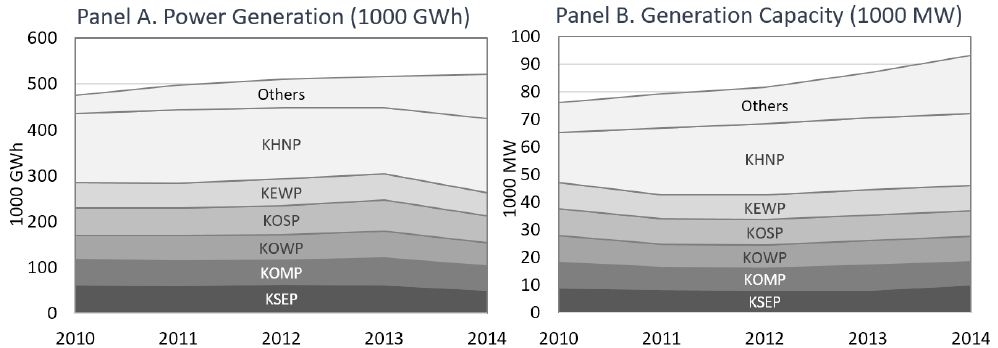
Figure 2. Power generation and plants capacity across power companies in Korea. Sources: Panel A–Korea Power Exchange and Panel B–Korea Statistical Information System (KOSIS). Note: KSEP = Korea South-East Power, KOMP = Korea Midland Power, KOWP = Korea Western Power, KOSP = Korea Southern Power, KEWP = Korea East-West Power, and KHNP = Korea Hydro & Nuclear Power.